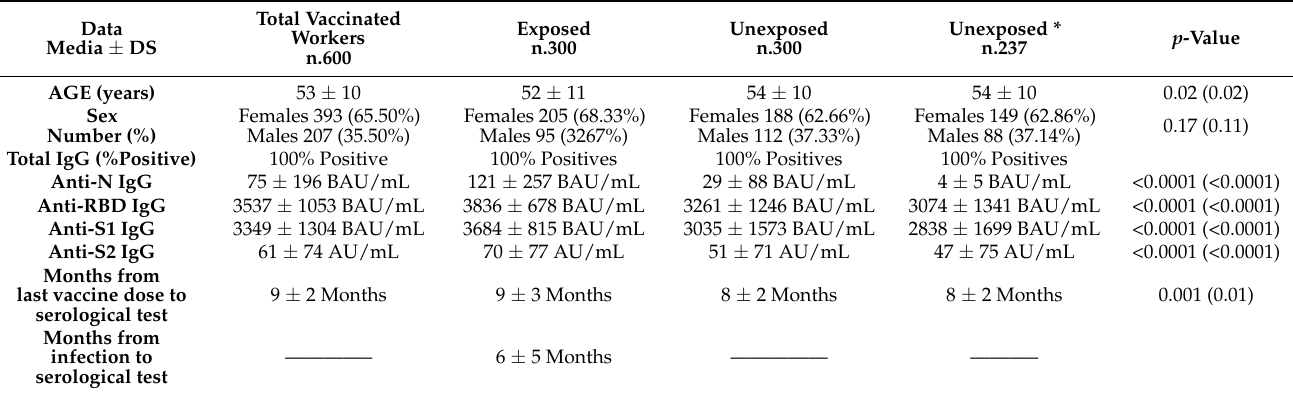
Table 2. Questionnaire and SARS-CoV-2 IgG Panel data with comparison between exposed and unexposed subjects.